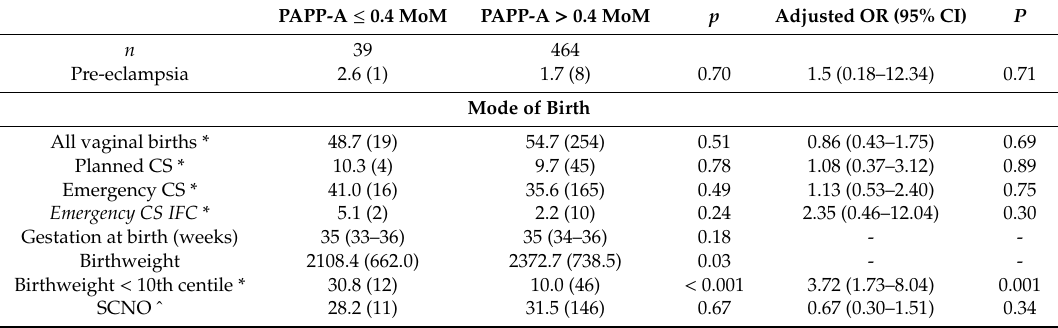
Table 4. Outcomes amongst those delivering prior to 37 weeks of